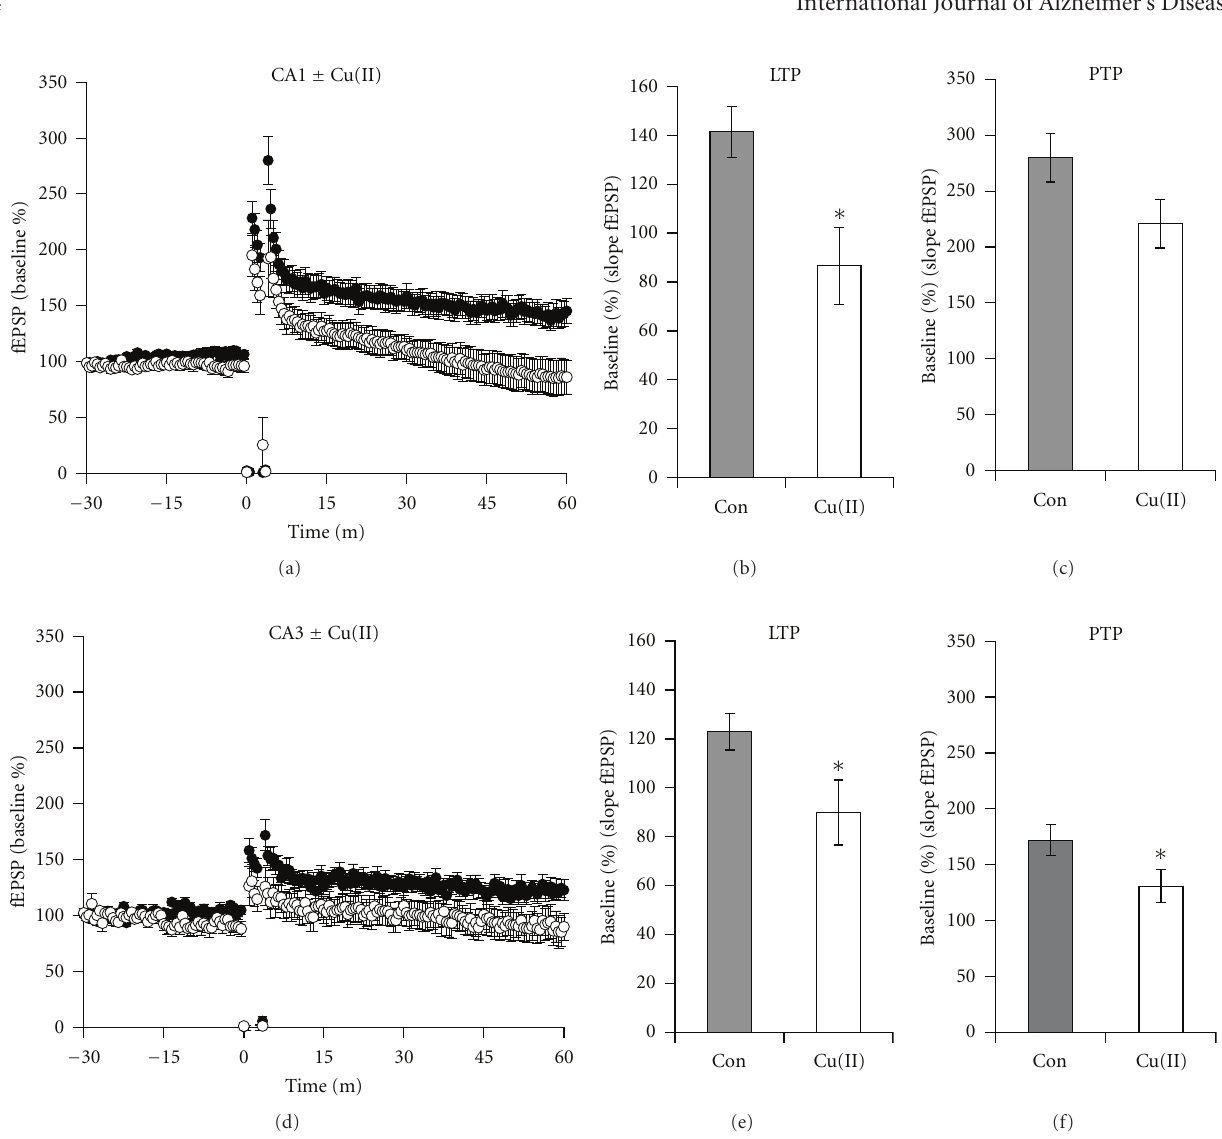
Figure 2: Copper inhibited LTP in the CA1 and CA3 regions of mouse hippocampal slices. (a) In the CA1 region, compared to control slices (black circles), LTP was inhibited by copper (open circles). (b) The average of the fEPSP slopes taken one hour after tetanus was significantly decreased from 141.4 ± 10.5% to 86.6 ± 15.7% in copper-treated slices ( P = 0 . 034, n = 8). (c) In the CA1 region, the peak PTP was reduced from 280 . 0 ± 21 . 8% to 220 . 9 ± 21 . 8% in copper-treated slices ( P = 0 . 069, n = 8). (d) Copper-inhibited LTP in the CA3 region of the mouse hippocampus, control groups are indicated by black circles and copper-treated groups are indicated by open circles. (e) The average fEPSP in the CA3 region measured one hour after tetanus was significantly decreased from 122 . 9 ± 7 . 4% to 89 . 9 ± 13 . 3% in copper-treated slices ( P = 0 . 016, n = 8). (f) In the CA3 region, the peak PTP was significantly reduced from 171 . 8 ± 13 . 9% to 130 . 8 ± 14 . 7% in copper-treated slices ( P = 0 . 039, n =